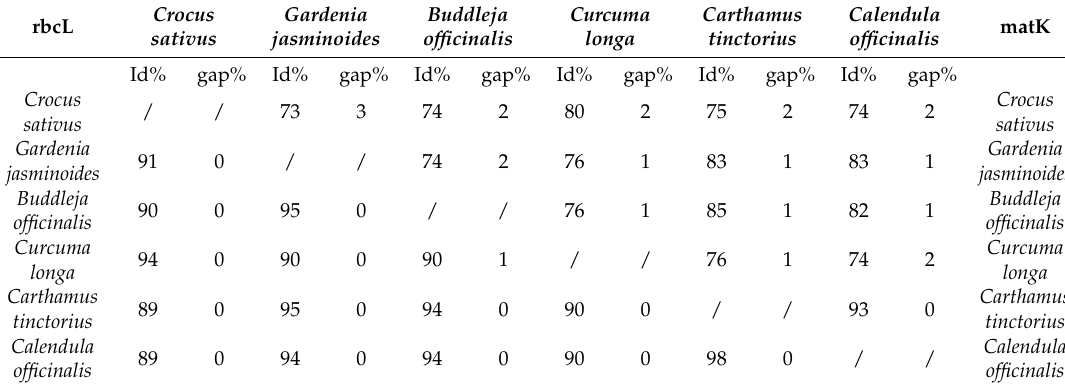
Figure 1. PCR amplification carried out with selective markers on: crocus (Croc), safflower (Cart), curcuma (Curc), calendula (Cal), gardenia (Gard) and buddleia (Budd). It is possible to see the high specificity of crocus, curcuma, safflower and calendula markers, while those for gardenia and buddleia also amplify in other species. For traceability purposes, it is important that the primers for the adulterants do not amplify in saffron and vice versa . Gardenia and buddleia were run on a separate gel, as clearly visible in the figure. Key: S (saffron), G (gardenia), C (safflower), B (buddleia), Cu (curcuma) and Ca (calendula). Table 4. Pairwise comparison of the tbcL, under the diagonal, and matK , above the diagonal, sequences for the different species. Percentages of nucleotide identity and gaps are reported. The accession numbers for the sequences are: crocus, KU230342 ( rbcL ) and KU230351 ( matK ); curcuma, KU230346 ( rbcL ) and KU230349 ( matK ); buddleia, KU230343 ( rbcL ) and KU230348 ( matK ); gardenia, KU230345 ( rbcL ) and KU230347 ( matK ); safflower, KU230344 ( rbcL ) and KU230350 ( matK ). For calendula, we considered the sequences available online in GenBank with Accession Numbers KM356099 ( rbcL ) and AF151446 ( matK